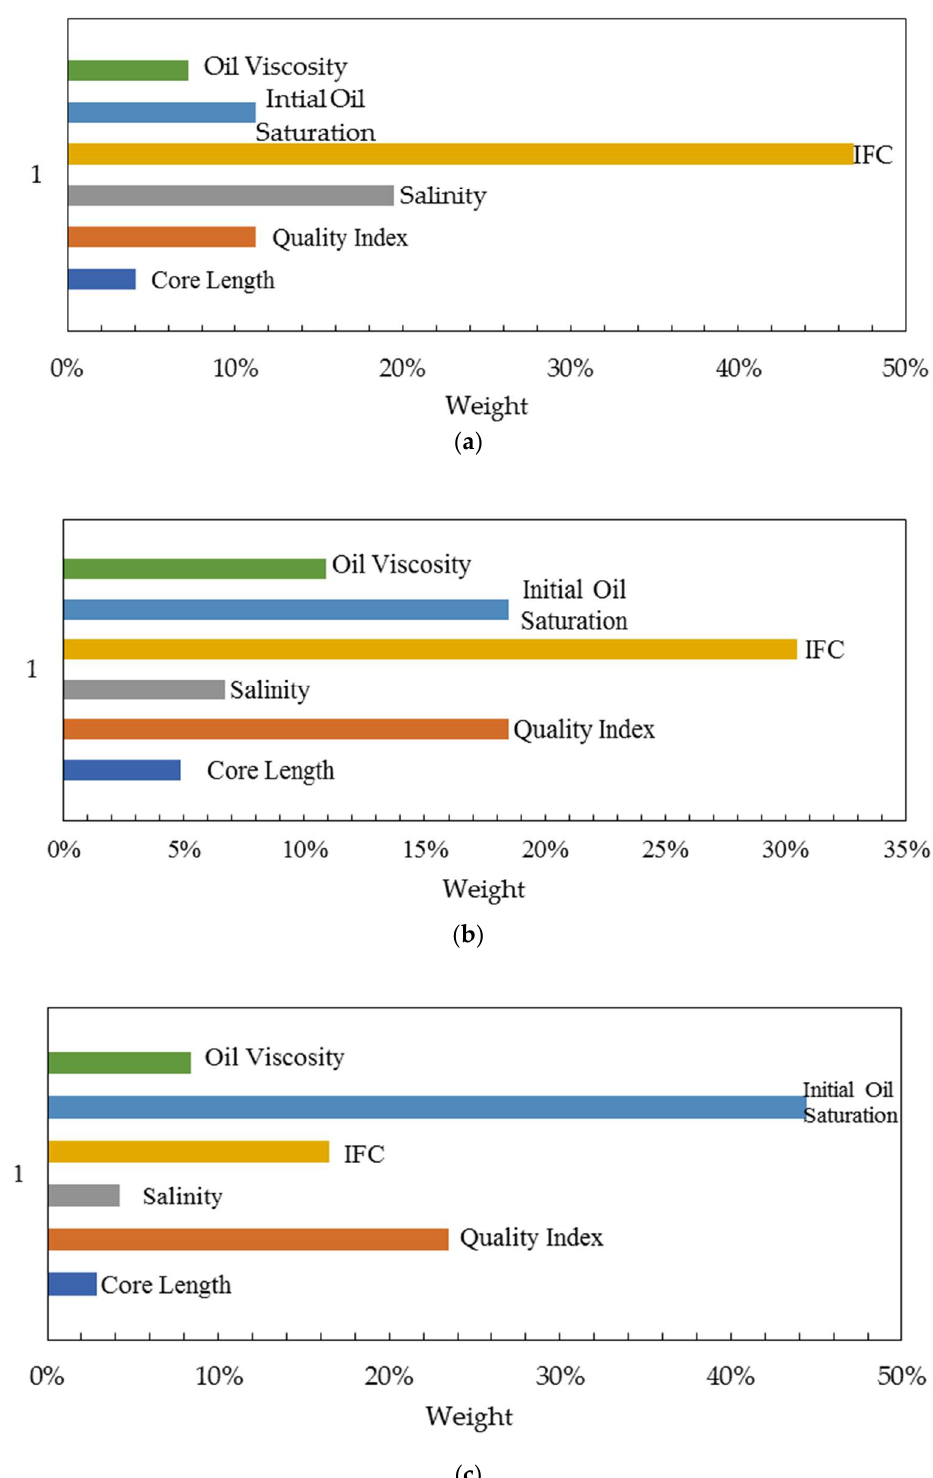
Figure 10. Importance weights of the controlling factors at the early stage ( a ), middle stage ( b ) and late stage ( c ).